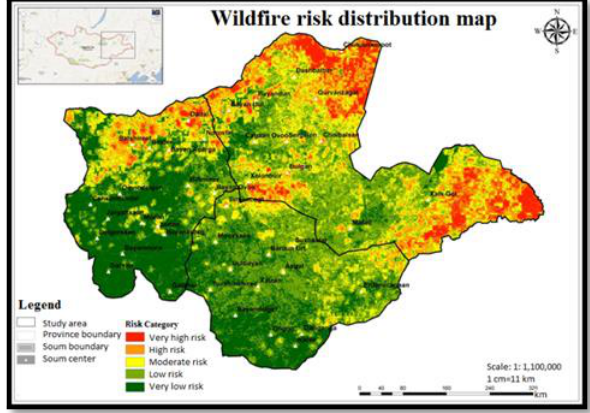
Figure 10. Accuracy of wildfire risk map in Study